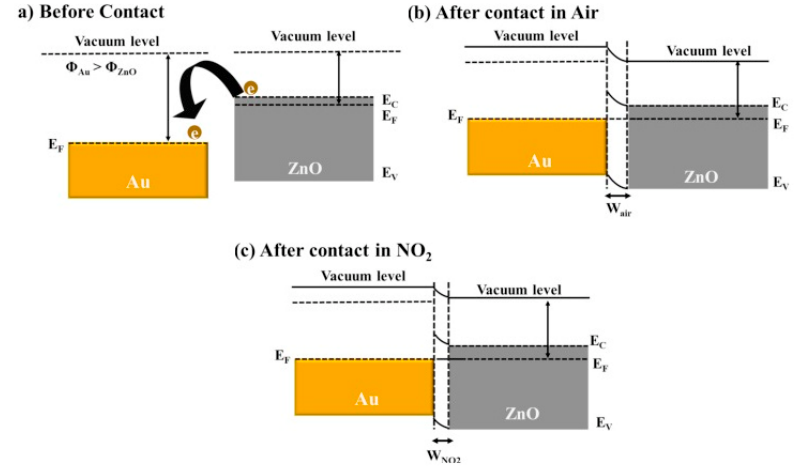
Figure 16. Schematic diagram of energy level of Au functionalized ZnO ( a ) before contact with air, ( b ) during contact with air, and ( c ) during contact with NO 2 [131].